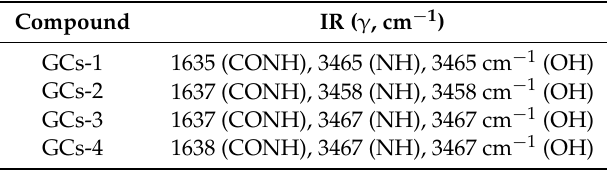
Scheme 2. The proposed mechanism, M 2+ for ( A ) nickel and ( B ) copper. Table 1. IR spectral data of compounds 1 – 4 . Table 1. IR spectral data of compounds 1 – 4 .